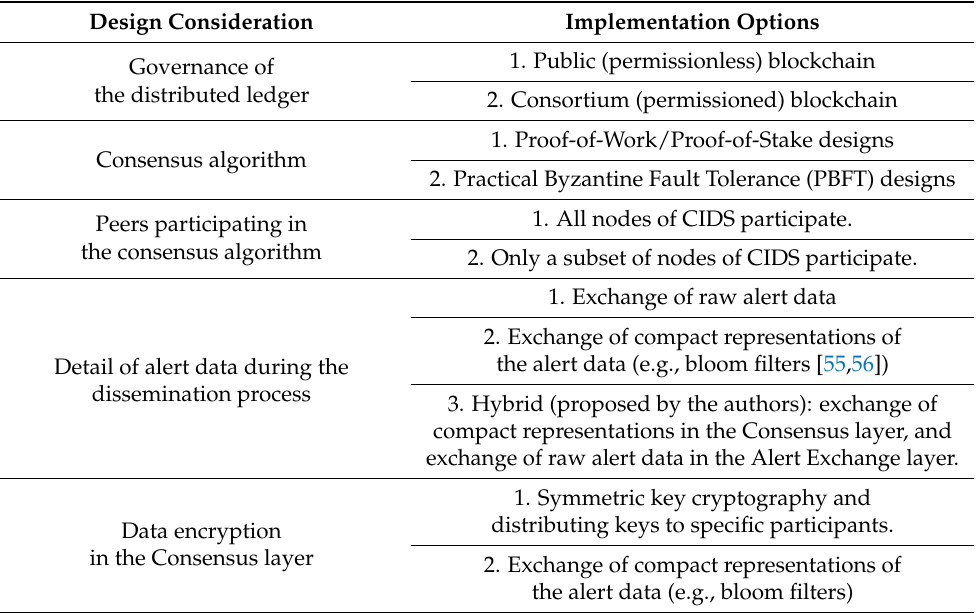
Table 5. Summary of implementation options for each design consideration mentioned in